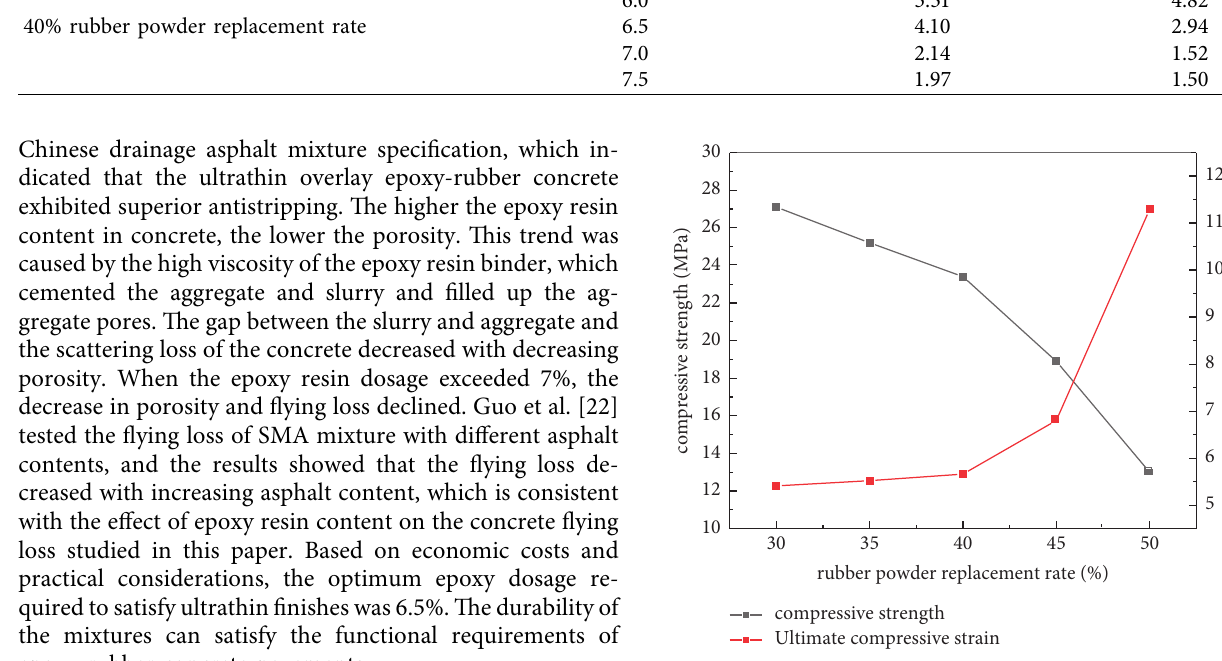
Figure 5: Relationship between rubber powder replacement rate and compressive strength of mixture.